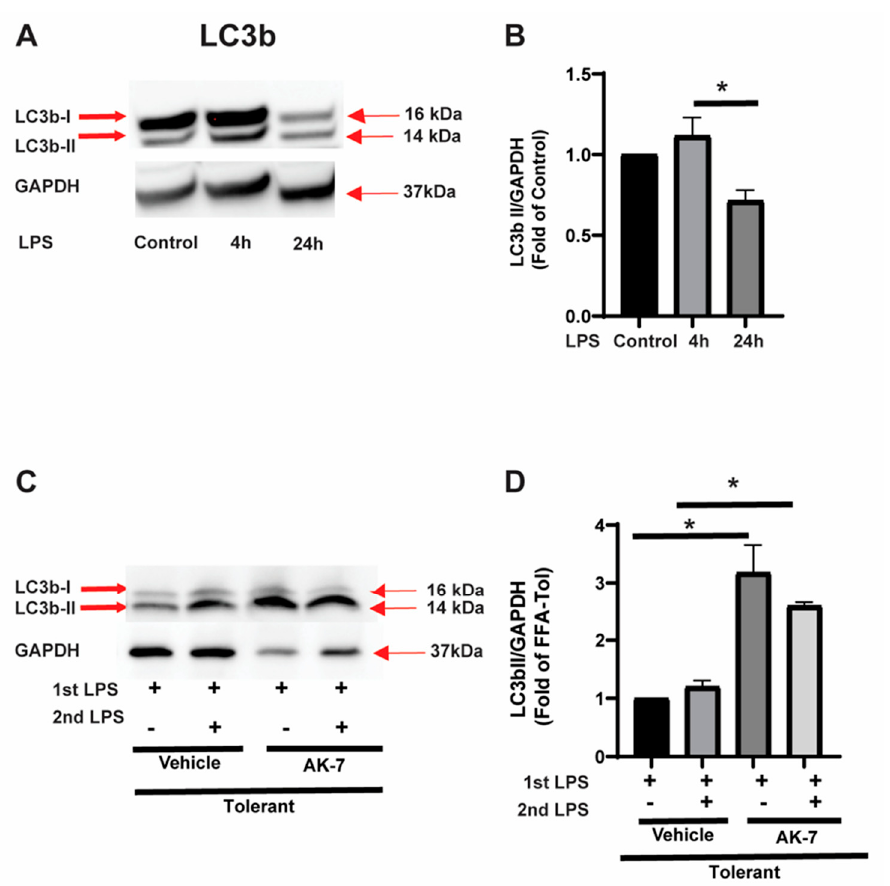
Figure 3. LC3b expression in sensitive and tolerant macrophages. Stearic acid (free fatty acid: FFA)-exposed sensitive and tolerant RAW264.7 cell macrophages (RAW) were stimulated with or without LPS for 4 h or 24 h. Loading control: GAPDH. ( A ) LC3b protein expression was detected in the cytosolic extract by Western blot. ( B ) Western blot image quan- tification of LC3b-II using image-J software (n = 5 blots; * p < 0.05). ( C ) FFA-exposed tolerant RAW cells were treated with SIRT2 inhibitor AK-7 (25 µM) or vehicle (DMSO; equal volume) and incubated further for 20 h and stimulated with or without LPS as indicated. LC3b protein expression was detected in the cytosolic extract by Western blot. ( D ) Western blot image quantification of LC3b-II using image-J software (n = 5 blots; * p <